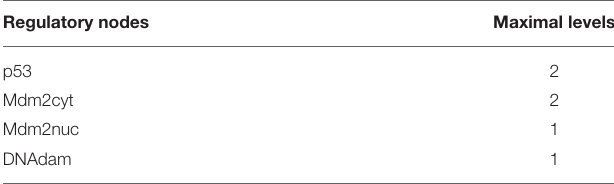
TABLE 1 | Regulatory nodes and maximal levels for the p53-Mdm2